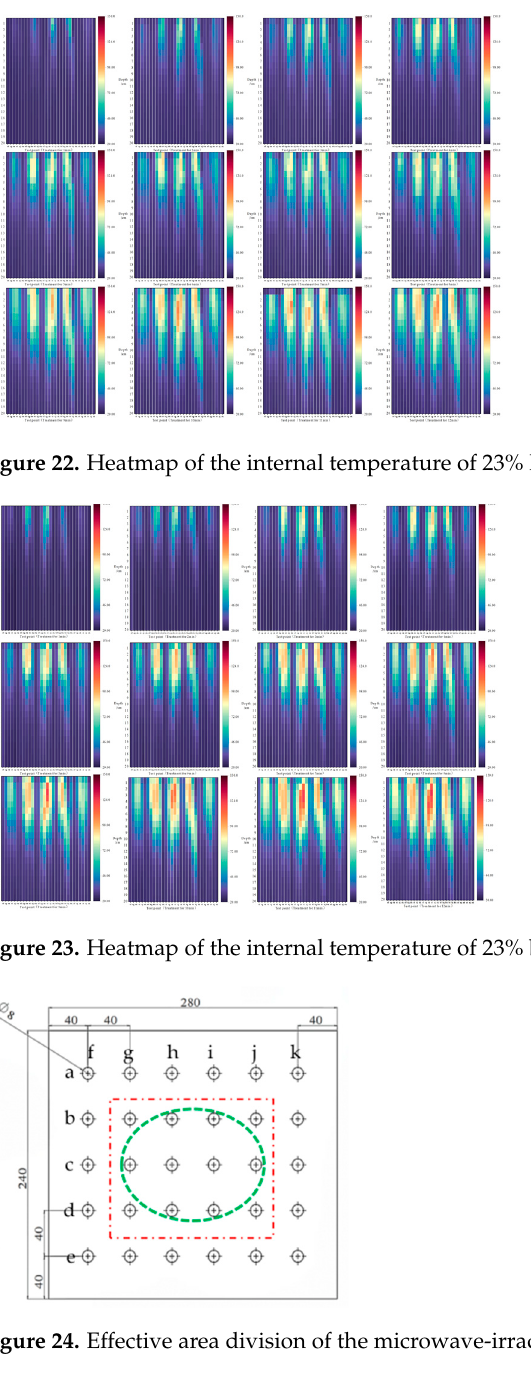
Figure 25. The division of the overall effective area of the microwave-irradiated soil model. In the equation, ⎯ T n is the average temperature of the soil layer, n is the soil layer number, and T bg , T bh , T bi ... T dj correspond to the temperature values obtained by the 12 sensors in the rectangular irradiation range, as shown in Figure 24. Soil depth and micro- wave irradiation time are used as independent variables, and the average temperature of each soil layer T n is used as a dependent variable. The variation law of the internal tem- perature of loess and black soil with irradiation time and soil depth was obtained by con- structing a three-dimensional surface, as shown in Figures 26 and 27. The figure intui- tively reflects the internal temperature of the loess and black soils in the 1–20 cm soil layer when the soil moisture content is 10%, 15%, 20%, and 23%. The soil temperature of loess and black soil is higher than that of other water-bearing soils when the water content is 10%, and lower than that of other water-bearing soils when the water content is 23%. When the soil moisture content is constant, the soil temperature increases with the in- crease in microwave irradiation time, and both soils maintain a high soil temperature in